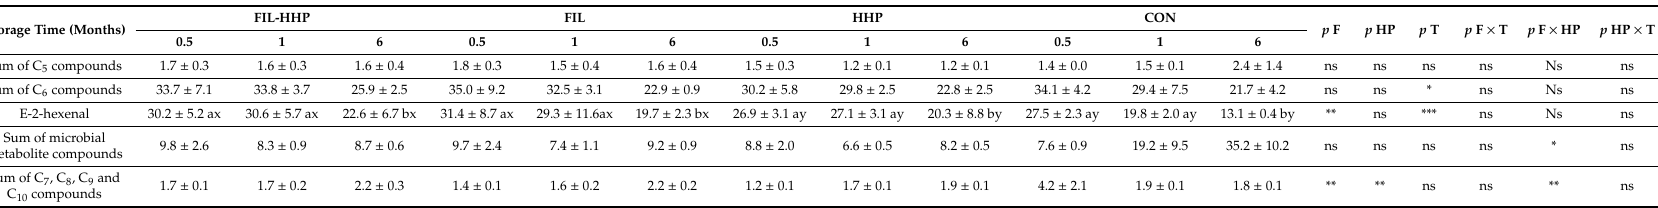
Table 3. Mean values and standard deviation of the volatile organic compound content for the four specimens of olive oil samples during storage.